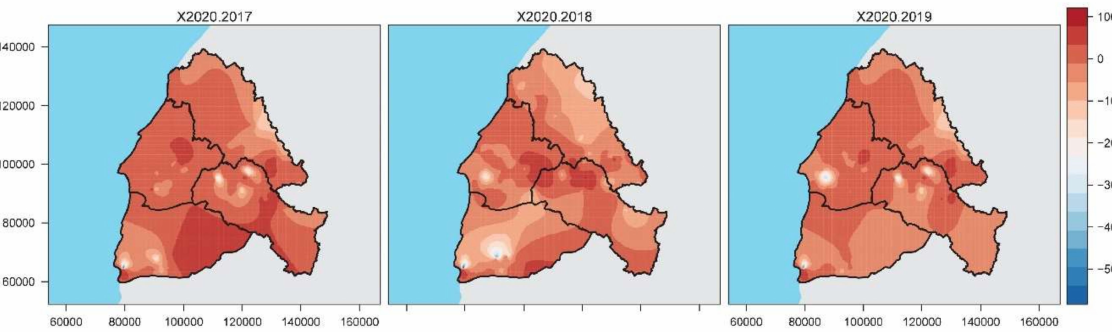
Figure 11. Comparison of the state of the EC in 2020 compared to the years 2017, 2018, and 2019. The maps in Figure 10 correspond to the presentation of the EC status in the study area for the sample campaigns from 2017 to 2020. In 2017, the EC varied between 550 and 7555 µ S/cm, with an average of 2185 µ S/cm; there was a decrease in the EC when moving away from the edge of the Atlantic Ocean. According to the quality